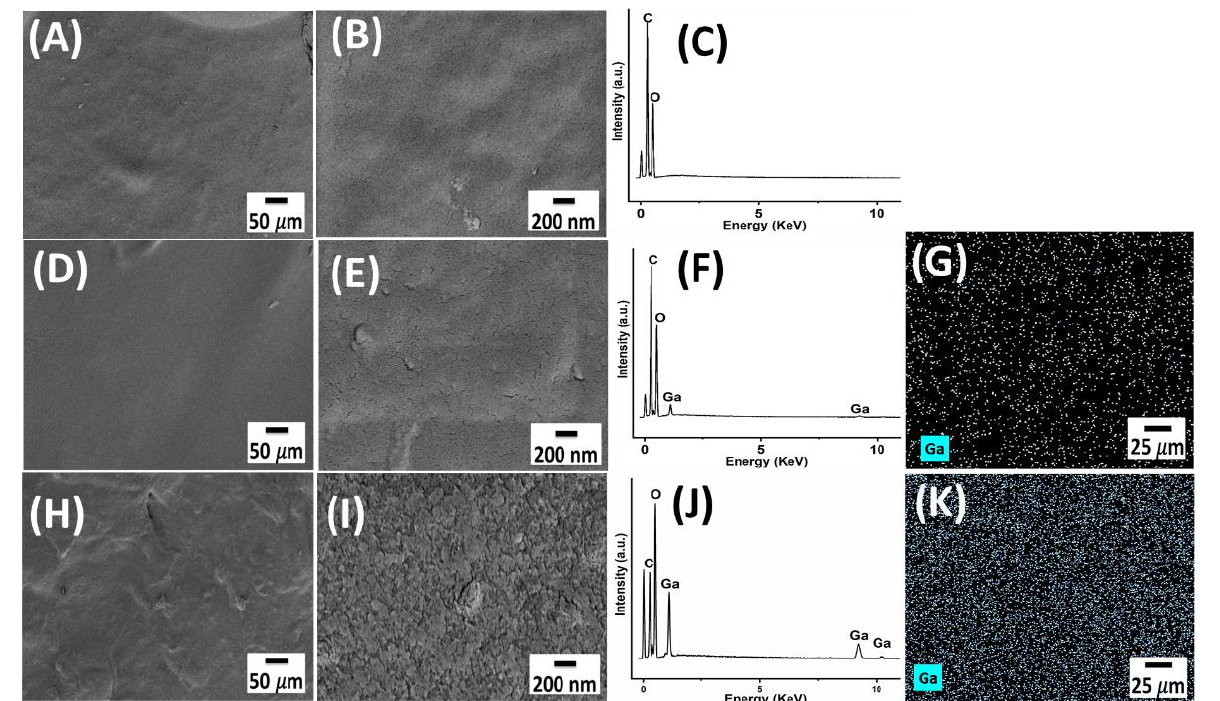
Figure 1. ( A , B ) SEM micrographs of CS at two magnifications, ( C ) EDX spectra of the respective film, ( D , E ) SEM micrographs of 1:8 Ga (III)-CS complex film at two magnifications, ( F , G ) EDX spectra and mapping of Ga in the 1:8 Ga (III)-CS complex film, ( H , I ) SEM micrographs of 1:1 Ga (III)-CS complex film at two magnifications, and ( J , K ) EDX spectra and mapping of Ga in 1:1 Ga (III)-CS complex film.